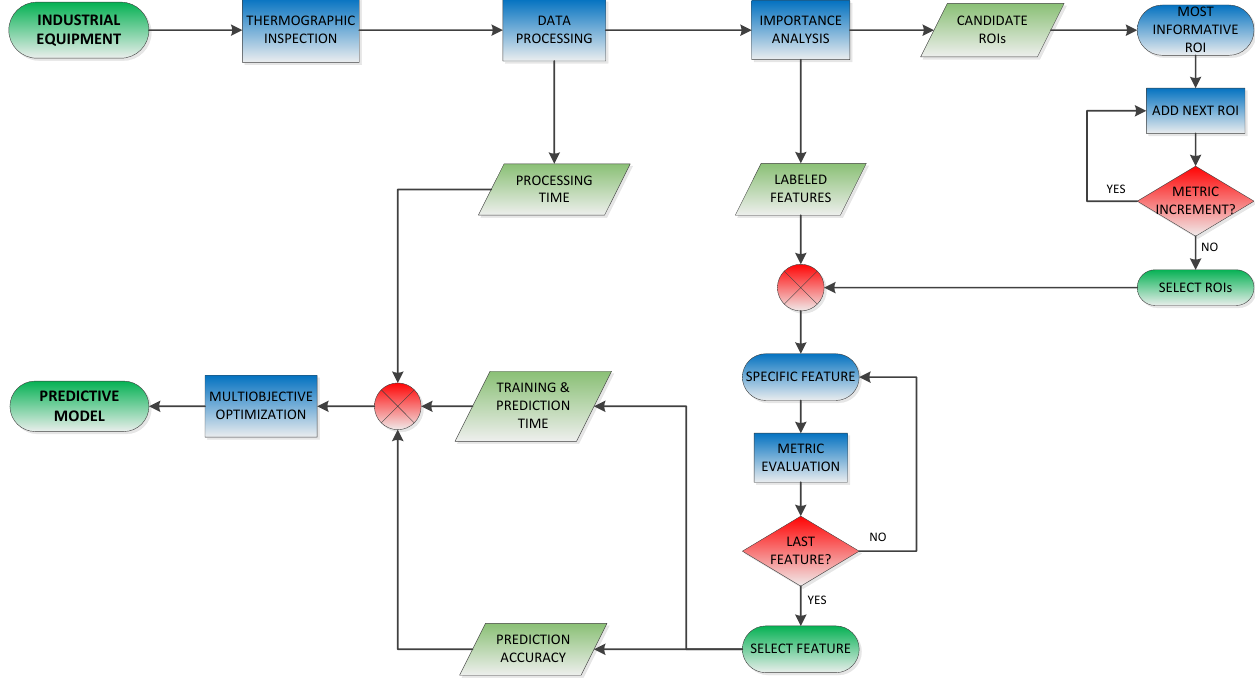
Figure 8. Flowchart of the proposed procedure to develop a robust and fast predictive maintenance system based on thermographic